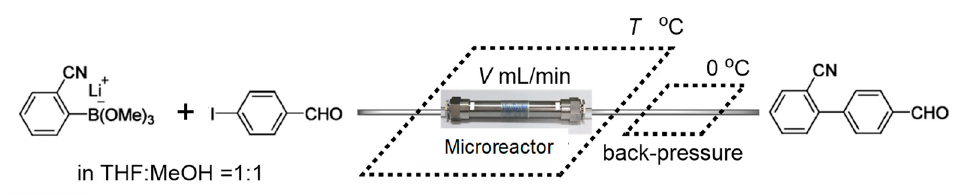
Figure 4. A single reactor system for optimizing Suzuki–Miyaura coupling reaction conditions.